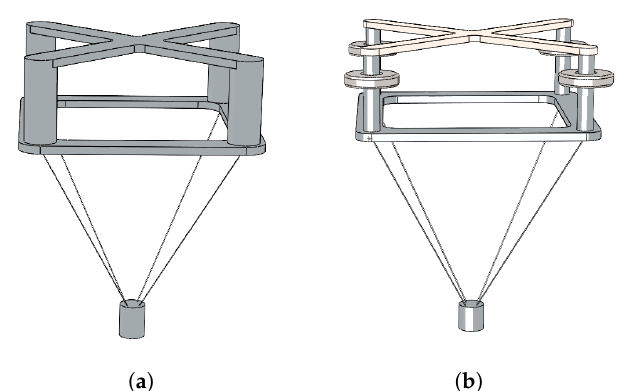
Figure 2. NautiluspPlatform ( a ) and hybrid wind and wave platform ( b ).